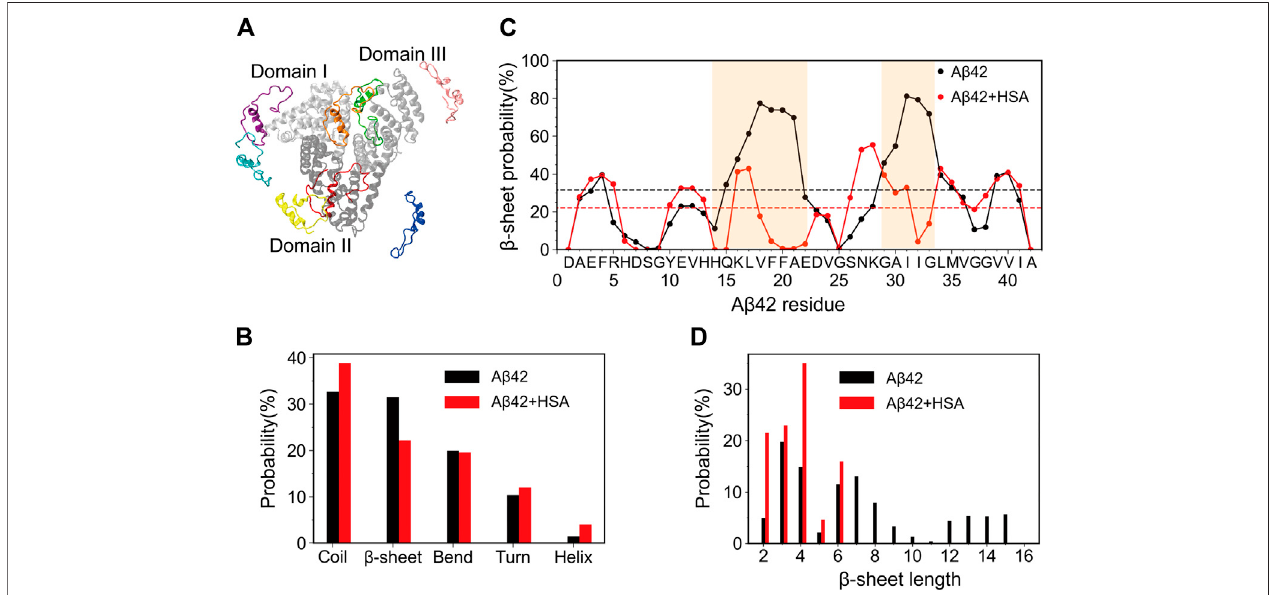
FIGURE1| StartingstructuresofsimulationsforA β 42withHSAandsecondary structurechangesofA β 42uponbindingtoHSA. (A) Superimpositionof8A β 42(in color) starting positions around HSA. Domains I, II, and III of HSA are shown in silver, gray, and light gray, respectively. (B) The average probability of each secondary structurecontent. (C) Residue-speci fi c β -sheet probability.Theaveragevalue ofeach curveisshown asahorizontaldashed line. Regions (H14-E22 and G29-G34) that display signi fi cant changes are highlighted by brown shading. (D) Histograms of β -sheet lengths of A β 42 in the two systems.